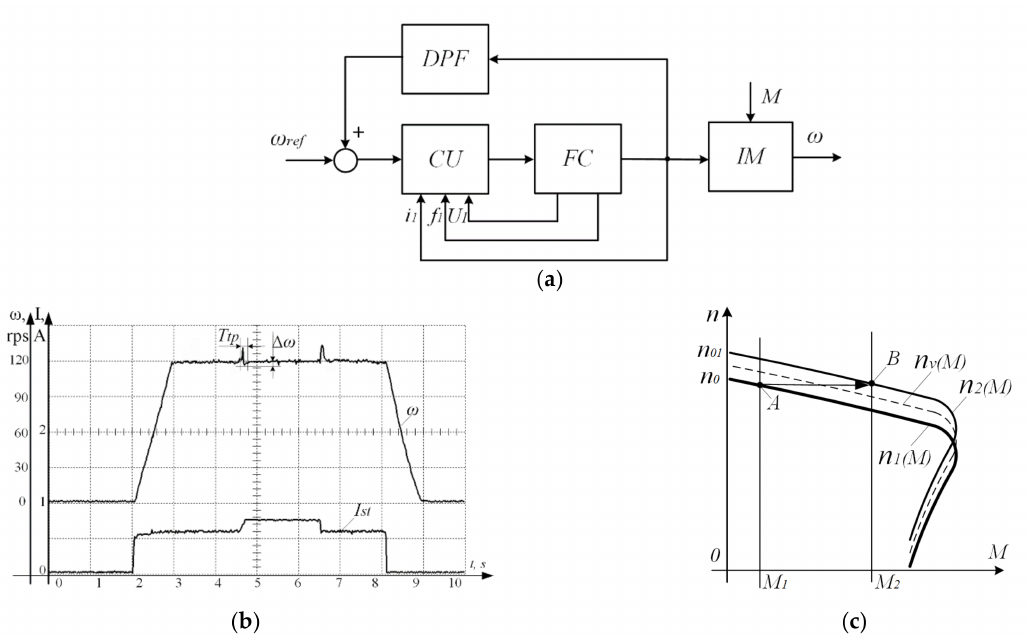
Figure 8. Block diagram of an AED with dynamic coupling by torque ( a ), transients ( b ) and me- chanical characteristics ( c ). n 1 ( M ) is the initial mechanical characteristic at low load, n 2 ( M ) is the mechanical characteristic corrected by DPF at increased voltage on the stator.